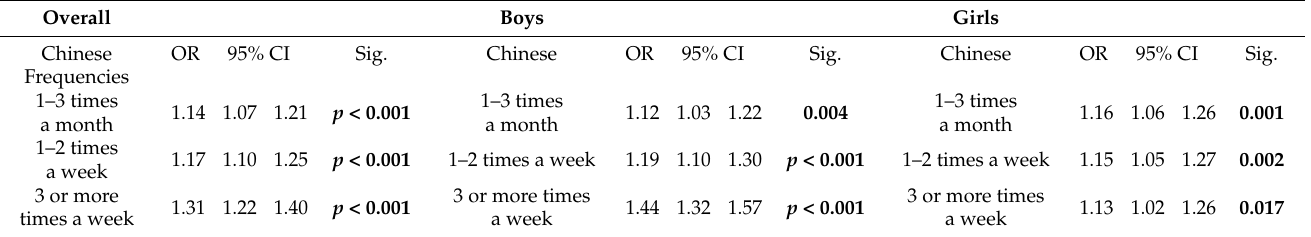
Table 3. Odds ratio and 95% CI for academic performance in relation to sports participation (Chinese).